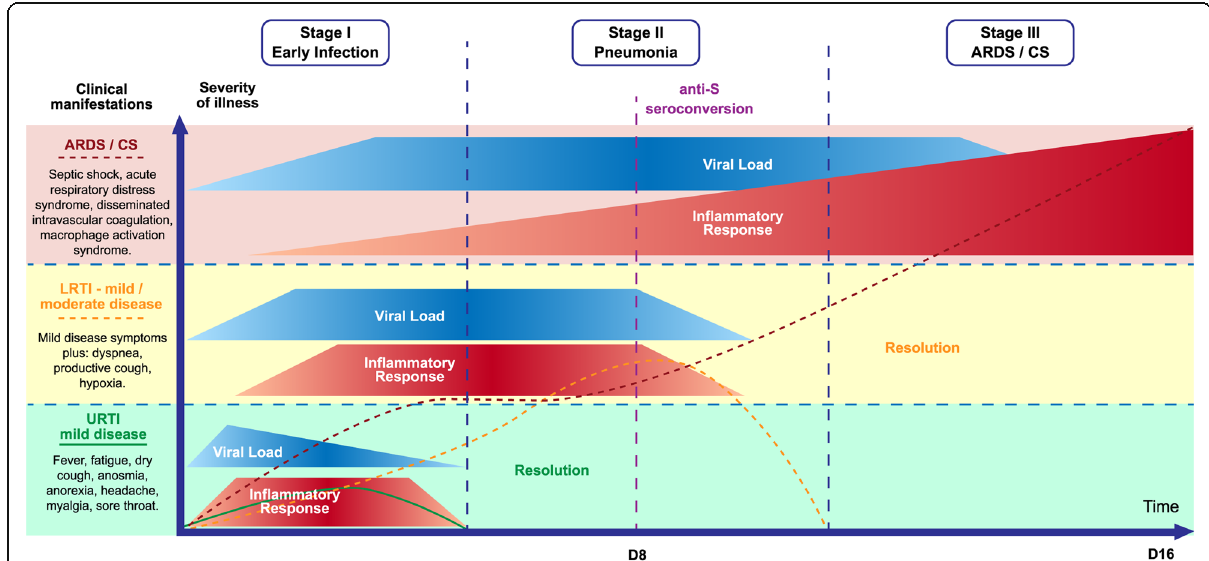
Fig. 2 Spectrum of severity and stages of COVID-19. UPRT – Upper Respiratory Tract Infection; LRTI – Lower Respiratory Tract Infection; ARDS – Acute Respiratory Distress Syndrome; CS – Cytokine